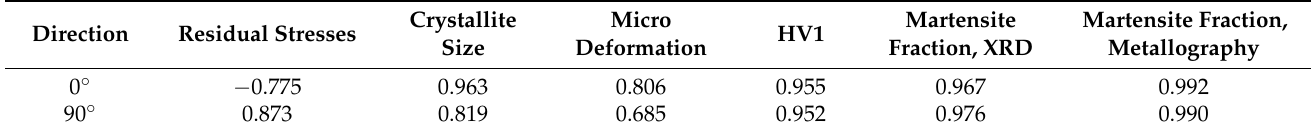
Table 2. Correlation coefficients for MBN.